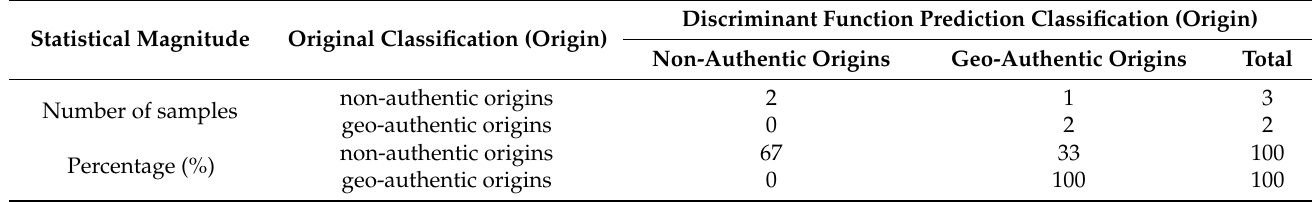
Table 3. Effect evaluation of discriminant function equations of two groups of S. tetrandra samples. Statistical